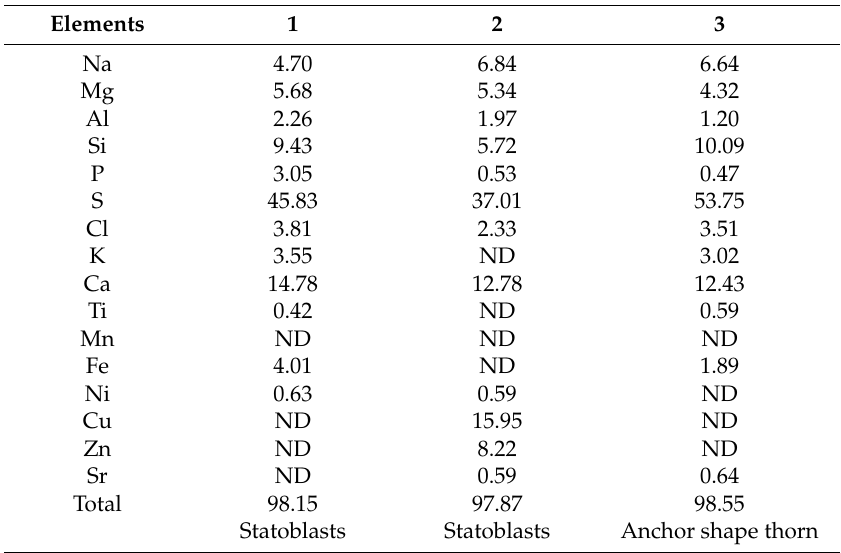
Table 4. Results of SEM-EDS semi-quantitative analyses of carbon-coated dried statoblasts and anchor-shaped thorns collected from Makiyama agricultural reservoir pond in November 2016, coated with carbon, indicating richness in Si, S, and Ca associated with traces of Sr. Values are represented as mass %.